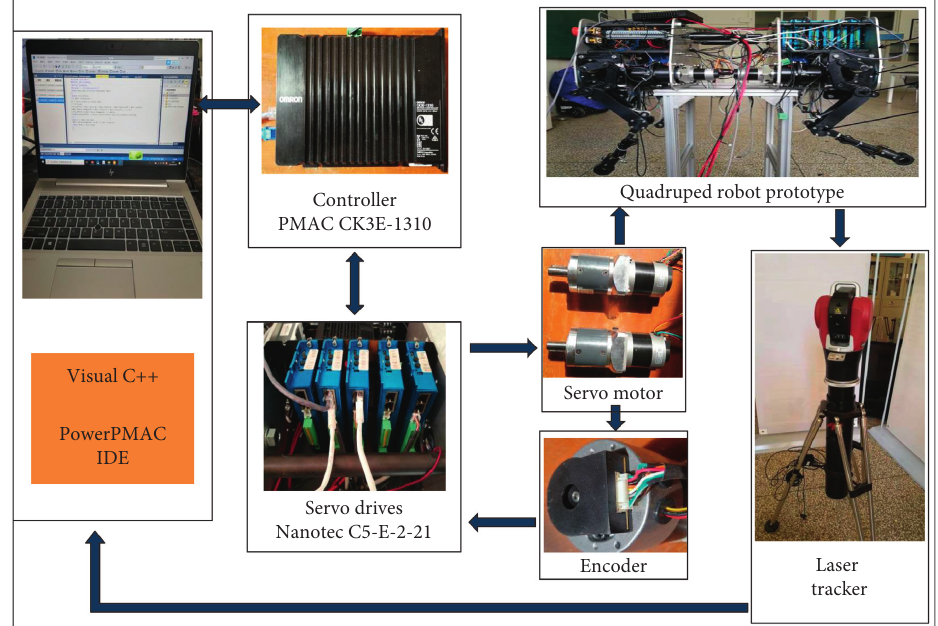
Figure 17: Experimental platform for bionic trajectory